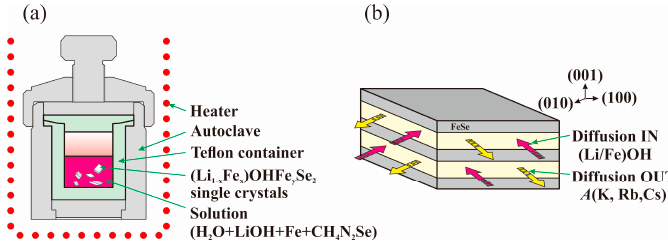
Figure 4. Growth of (Li 1 − x Fe x )OHFeSe single crystals via hydrothermal ion exchange. ( a ) Schematic apparatus of the autoclave used for the crystal growth; ( b ) illustration of the Li/Fe–O–H ions diffusing in between the FeSe layers and the A ions diffusing out from the A x Fe 2 − y Se 2 ( A = K, Rb, and Cs) precursors during the hydrothermal growth process [53]. Reprinted with permission from IOP. All rights reserved.